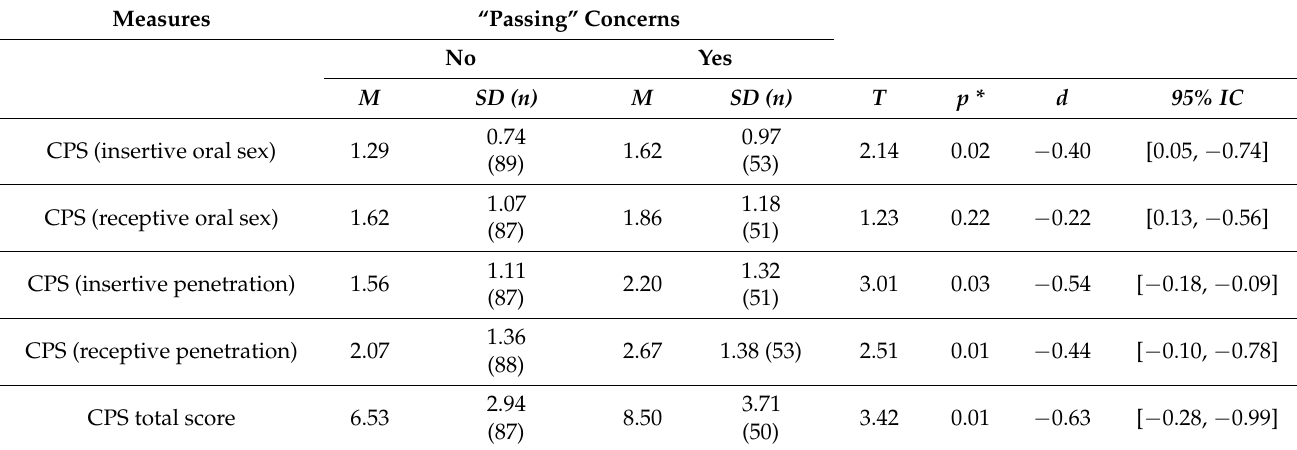
Table 4. Differences in CPS in TM and TW with and without “passing” concerns.